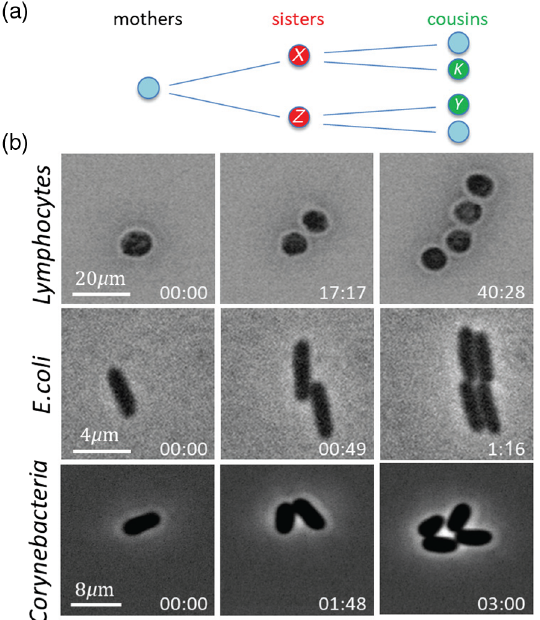
FIG. 1. (a) Schematic illustration of the symmetric self- replication process that generates two nearly identical sister cells at each division, with sister cells in red (middle) and cousin cells in green (on the right). (b) Single-cell phase-contrast images of the cell-cycle duration in various cells. The time labels are in